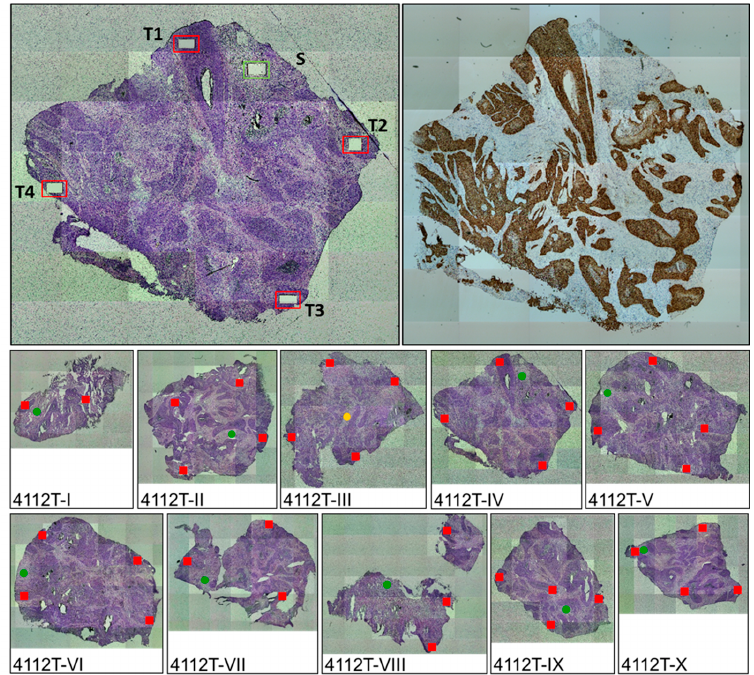
Figure 1. Intra-tumor heterogeneity analyses. Ten tissue blocks (I-X) of tumor 4112 were available. Left upper panel: Hematoxylin and eosin (HE)-stained section of block IV after micro-dissection; S: stroma, T1 to T4: tumor. ( Right upper ) panel: p16-staining of block IV to guide micro-dissection; ( Middle and lower ) panel: HE stained sections of all blocks. Squares and circles refer to micro-dissected tumor and stroma areas, respectively. Red, and green colors indicate the presence and absence of the viral junction, respectively. Yellow indicates a marginally positive result.